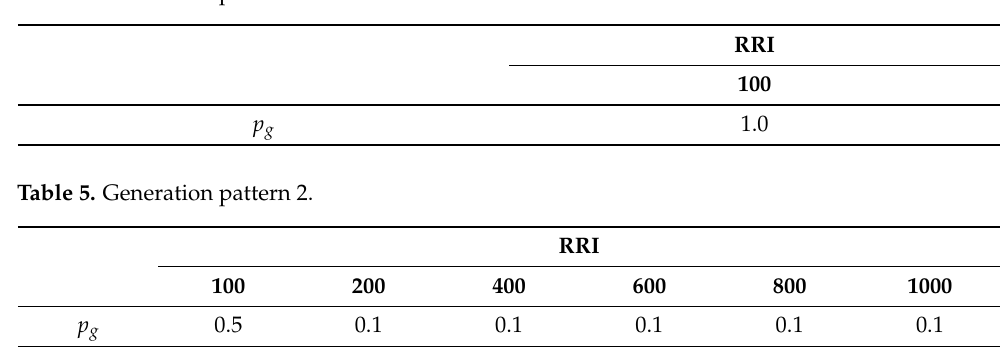
Table 4. Generation pattern 1.